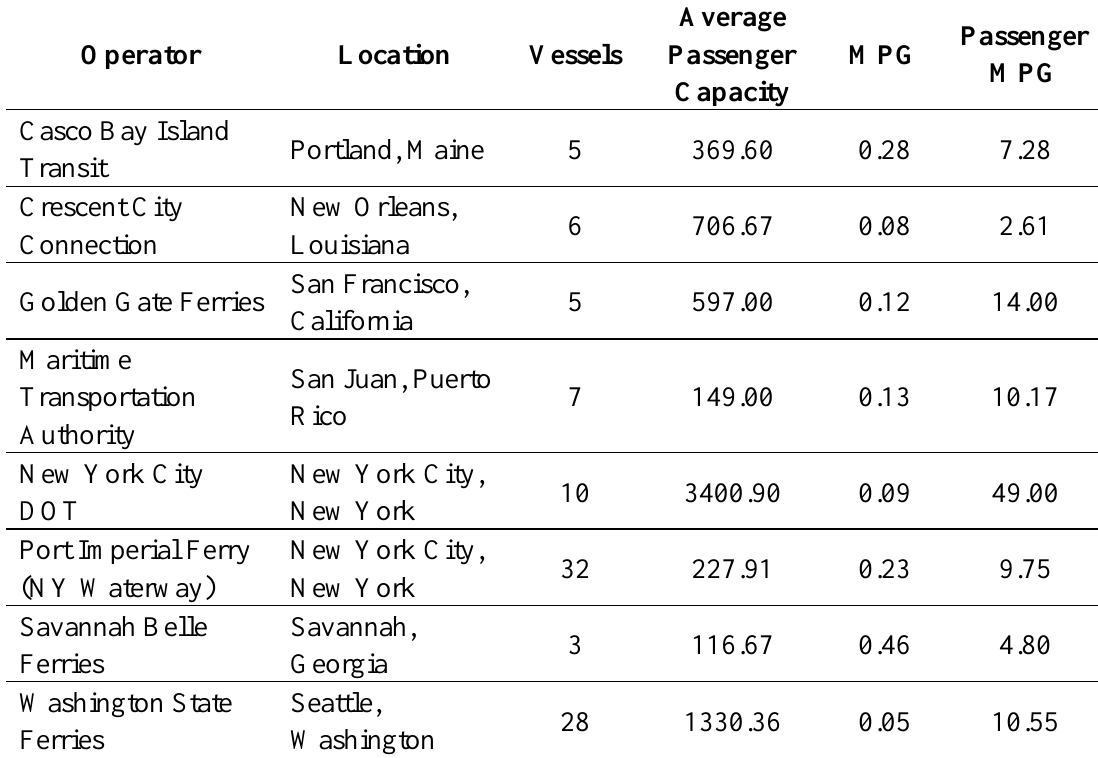
Table 1. Year 2008 Diesel Fuel Consumption by Selected U.S. Ferry Boat Operators 1